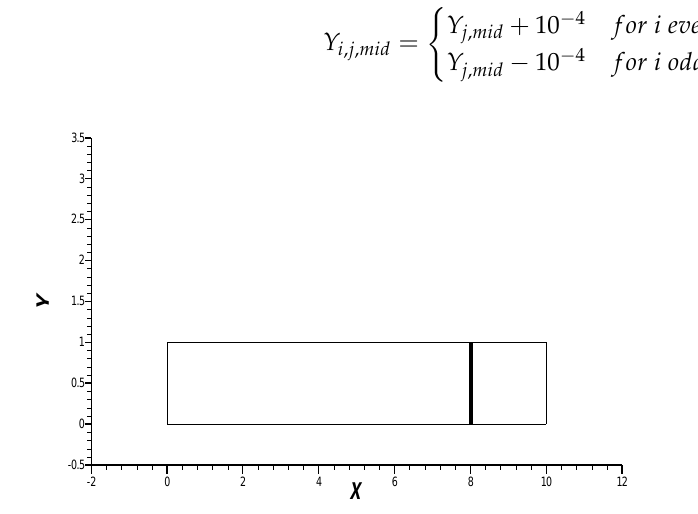
Figure 5. The initial density contour and axis lines.